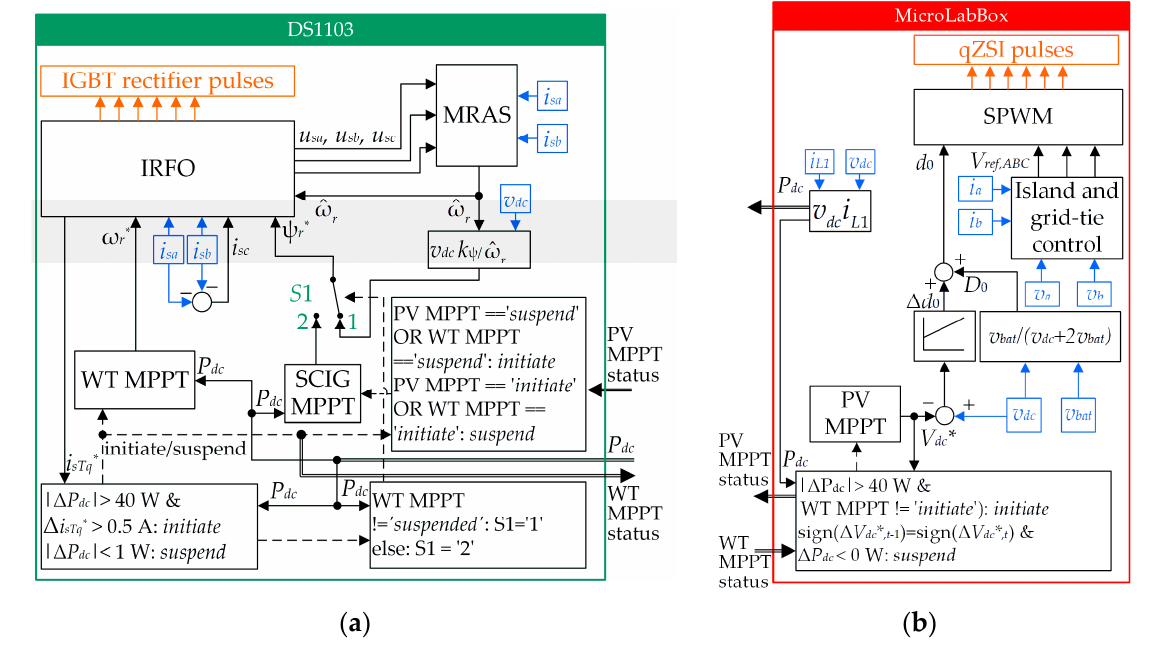
Figure 2. Proposed control algorithms: WT and SCIG control ( a ) and PV and qZSI control ( b ).